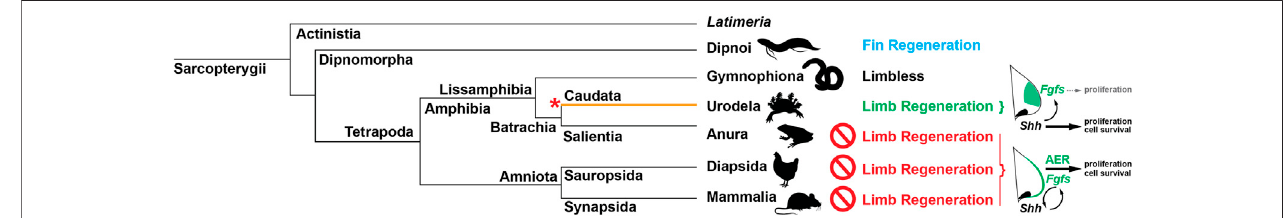
FIGURE 6 | Limb regenerative ability may have evolved uniquely in caudates. Comparison of developmental mechanisms among tetrapods has revealed that urodeles possess a derived mode of limb development compared to anurans and amniotes including, absence of a morphological and molecular AER, mesenchymal restriction of canonical AER- Fgfs , absence of a positive feedback loop between Fgf and Shh signaling, and reliance on Shh-signaling to regulate proximal-distal outgrowth via cell proliferation and survival (orange line). Correlating with this unique mode of limb development, urodeles are the only extant tetrapods capable of complete limb regeneration at any post-embryonic life stage (larva, juvenile, or adult). One possible explanation for this tight correlation is that limb regenerative ability evolved within caudates as their mode of limb development was modi fi ed from the ancestral tetrapod state to reside within the mesenchymal tissue compartment (red asterisk). This opposes the hypothesis that limb and fi n regenerative ability have a common origin among Sarcopterygii-with anurans and amniotes having lost limb regenerativeability(Nogueiraetal.,2016).Thishypothesisisbasedoncommongeneexpressiondataderivedfromregenerationofcartilaginouselementsinlung fi sh fi ns, a process similar to the regeneration of a cartilage spike in amputated Xenopus